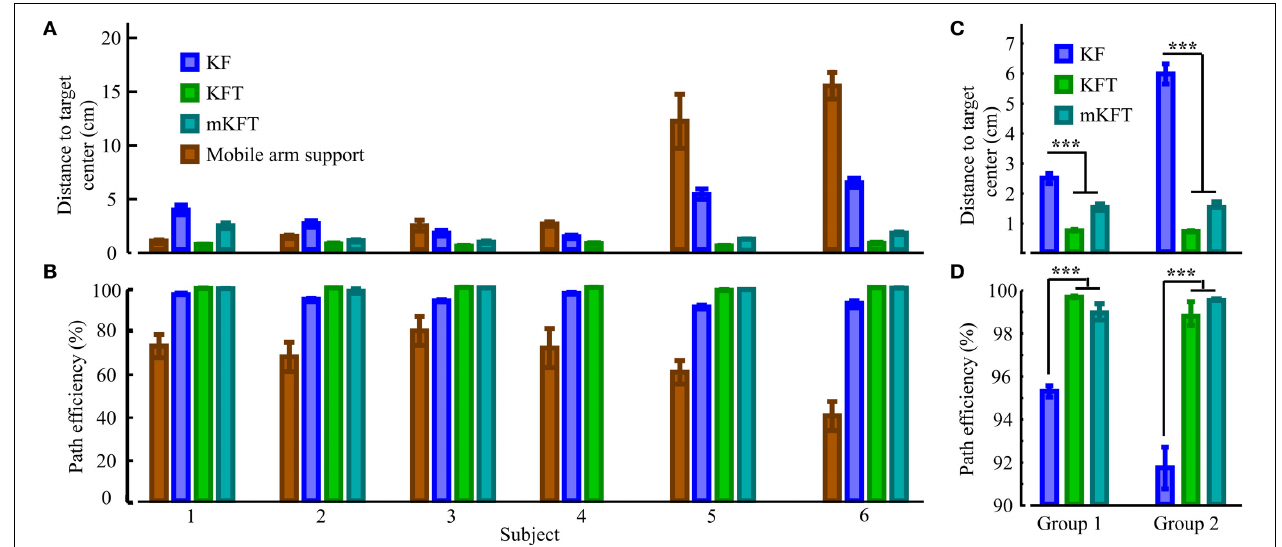
FIGURE 4 | Influence of subject impairment on decoder performance. By subject in order of increasing impairment, along with perfect target information case (KFT) and volitional reach performance using mobile arm